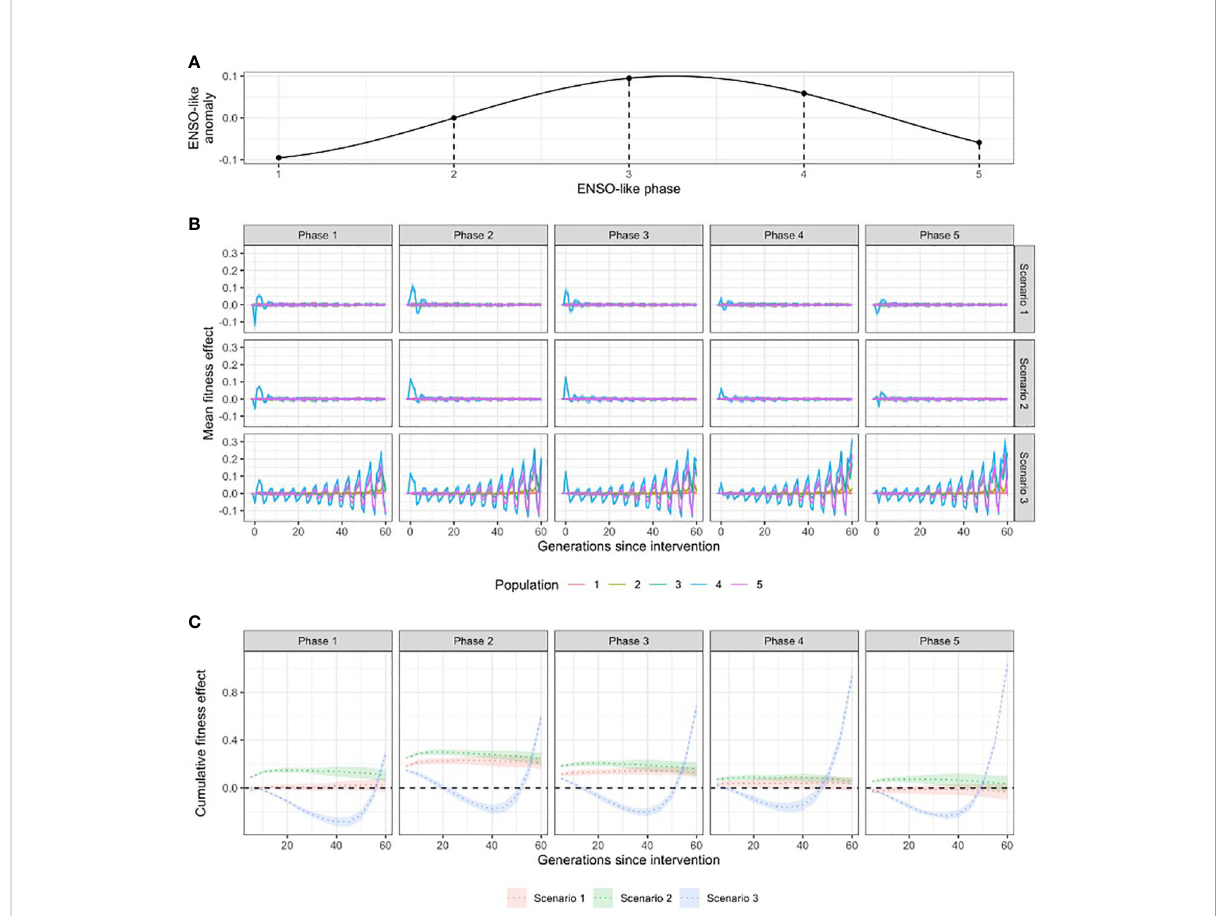
FIGURE 3 (A) Schematic of the ENSO-like anomalies; (B) the in fl uence of the timing of interventions in relation to ENSO-like phases on fi tness effect; and (C) the cumulative fi tness effect (over generations) of interventions in the target population (population 4) at different ENSO-like